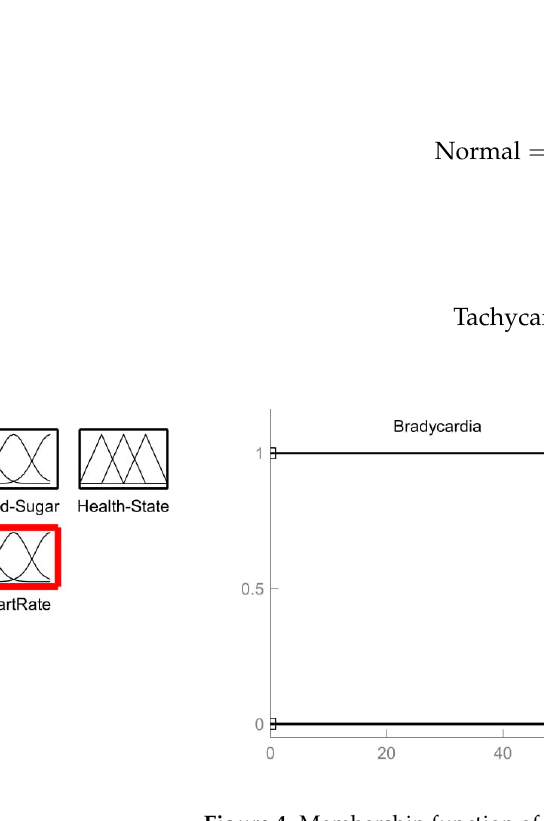
Figure 4. Membership function of Heart Rate in BPM.